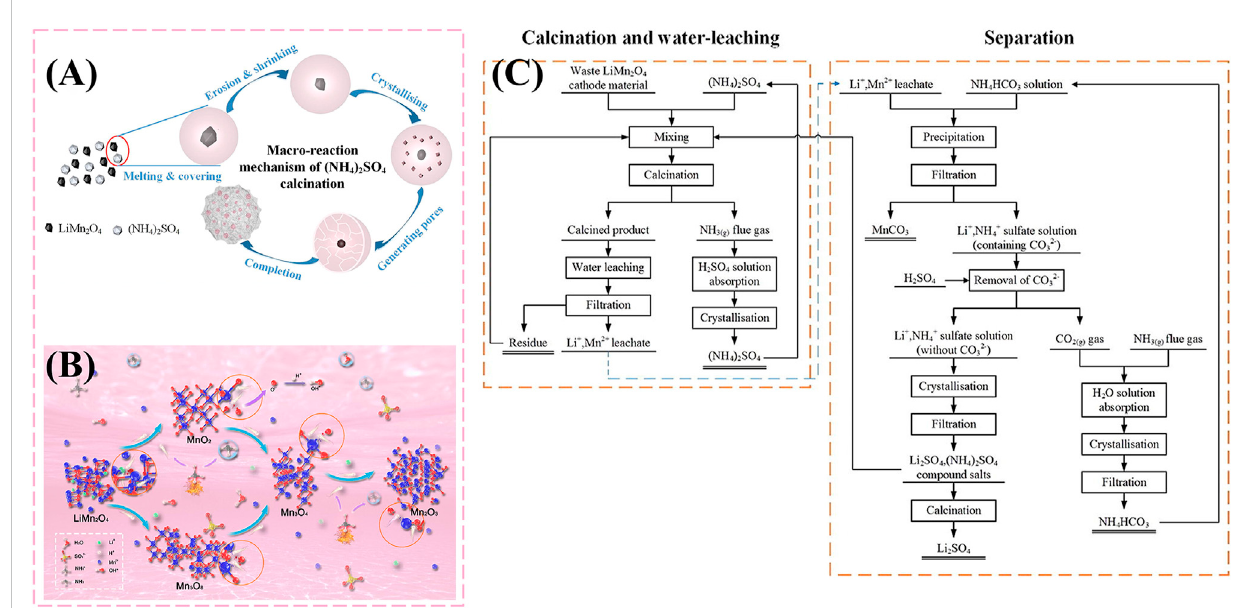
FIGURE 2 The mechanisms of spent LMO cathode material calcined with (NH 4 ) 2 SO 4 : (A) Macro-reaction mechanism; (B) Micro-reaction mechanism; (C) Flowchart of the recovery process of spent LMO cathode